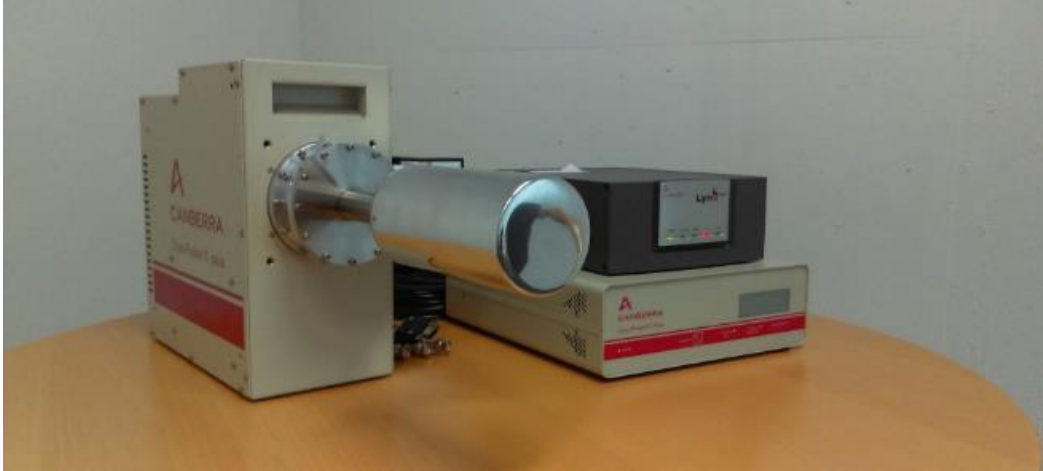
Figure 3: HPGe-Detectors by Mirion Technologies Canberra